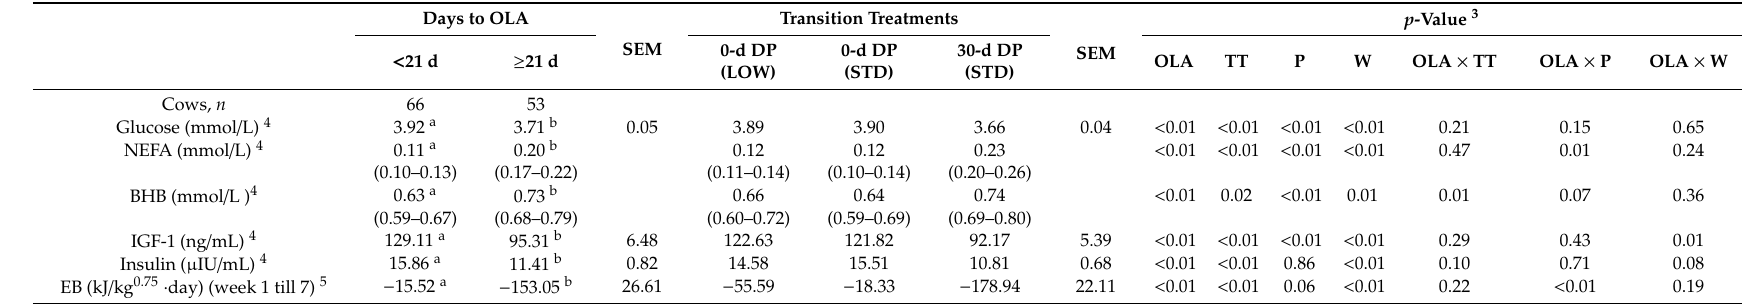
Table 4. Relationship between days to onset of luteal activity (OLA) and postpartum 1 plasma metabolites and metabolic hormones of cows after di ff erent transition treatments 2 . Days to OLA Transition Treatments SEM